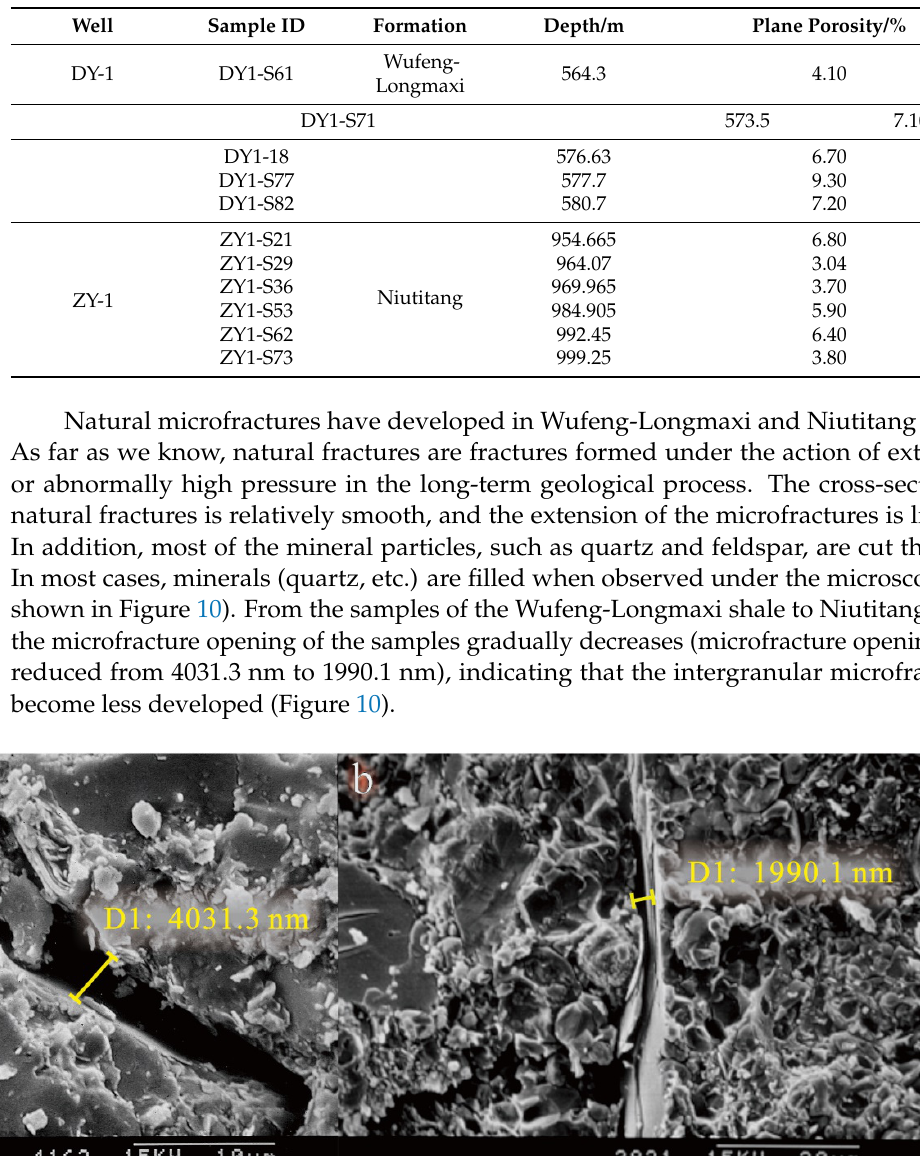
Table 10. The plane porosity of the intergranular pores in the Wufeng-Longmaxi Formation and Niutitang Formation.